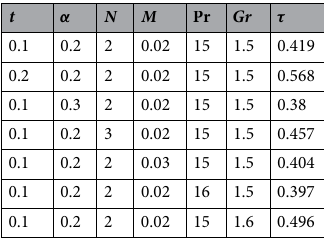
Table 1. Skin-friction.